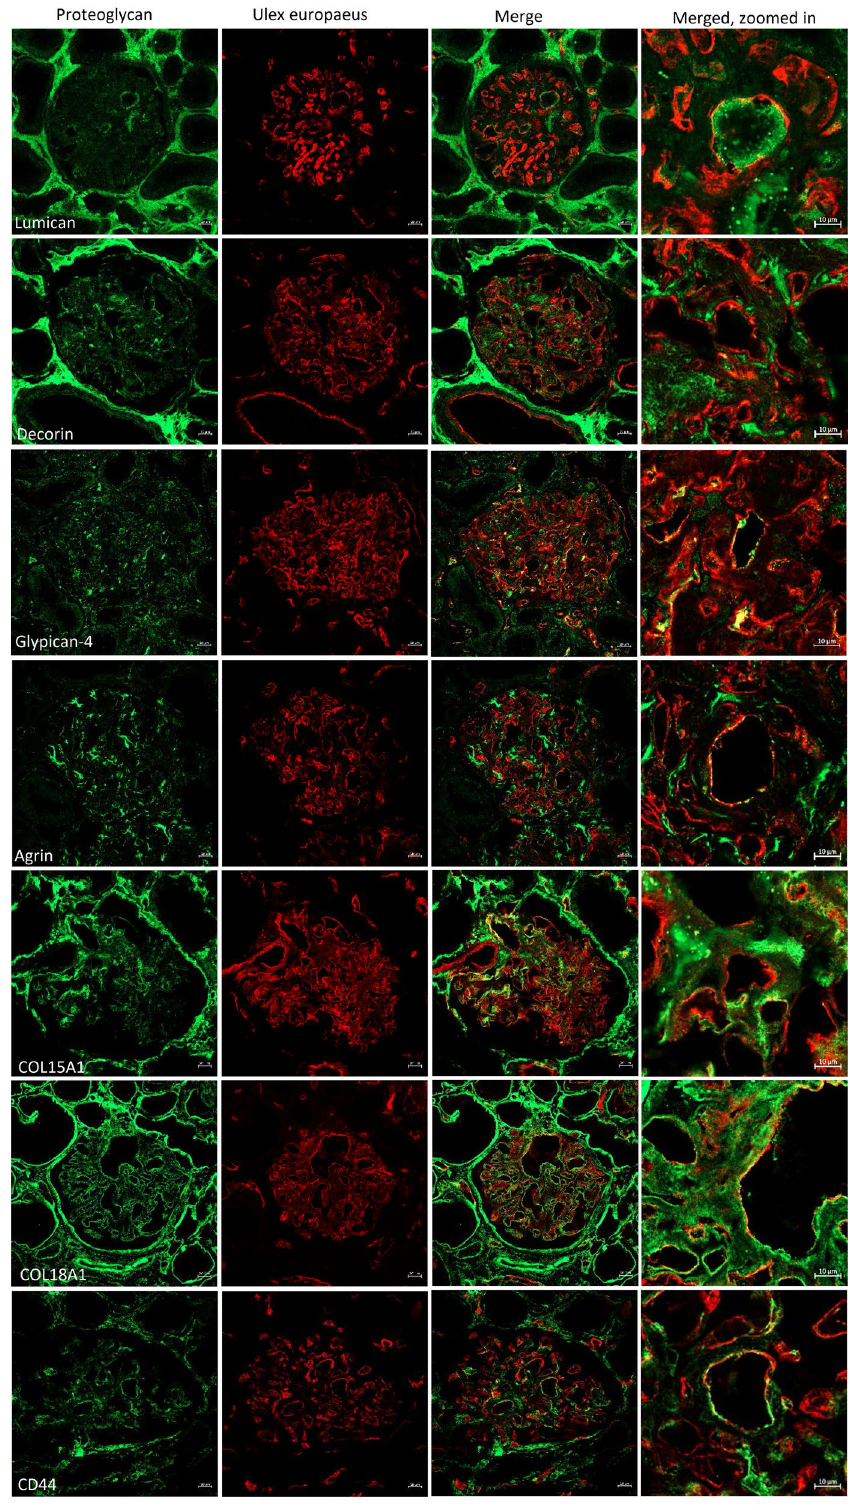
Figure 4. Expression of proteoglycans in the human glomerular endothelium. Immunofluorescence of proteoglycans and Ulex europaeus agglutinin I, a marker for endothelial cells (red), confirmed expression of (in green) lumican, decorin, glypican-4, agrin, collagen 15 alpha 1 chain, collagen 18 alpha 1 chain and CD44 in the glomerulus of human kidney sections. Co-localization is seen as yellow. Scale bars for pictures of full glomeruli represent 20 µm, zoomed in images 10